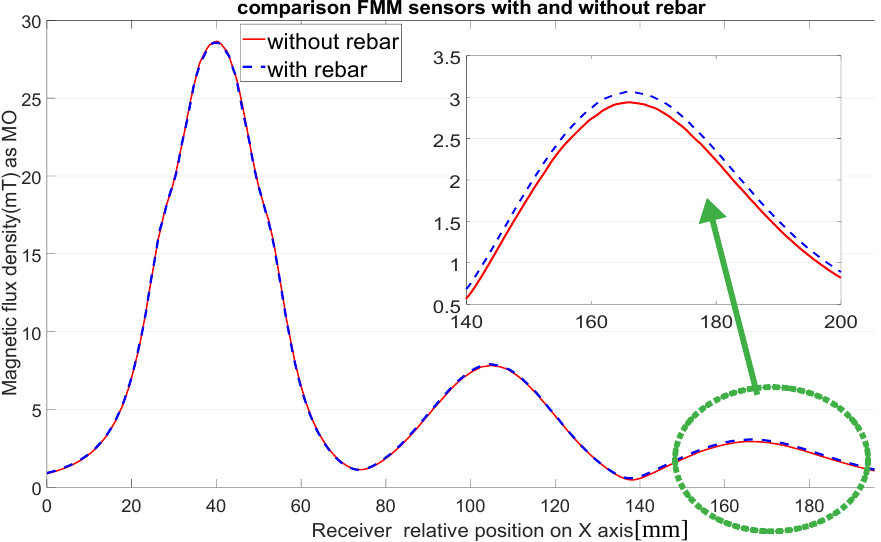
Figure 16. Comparison of raw MO values for the multi-tool model when applying an identical tool geometry value: 25 mm × 25 mm × 1 mm for Configurations 2 and